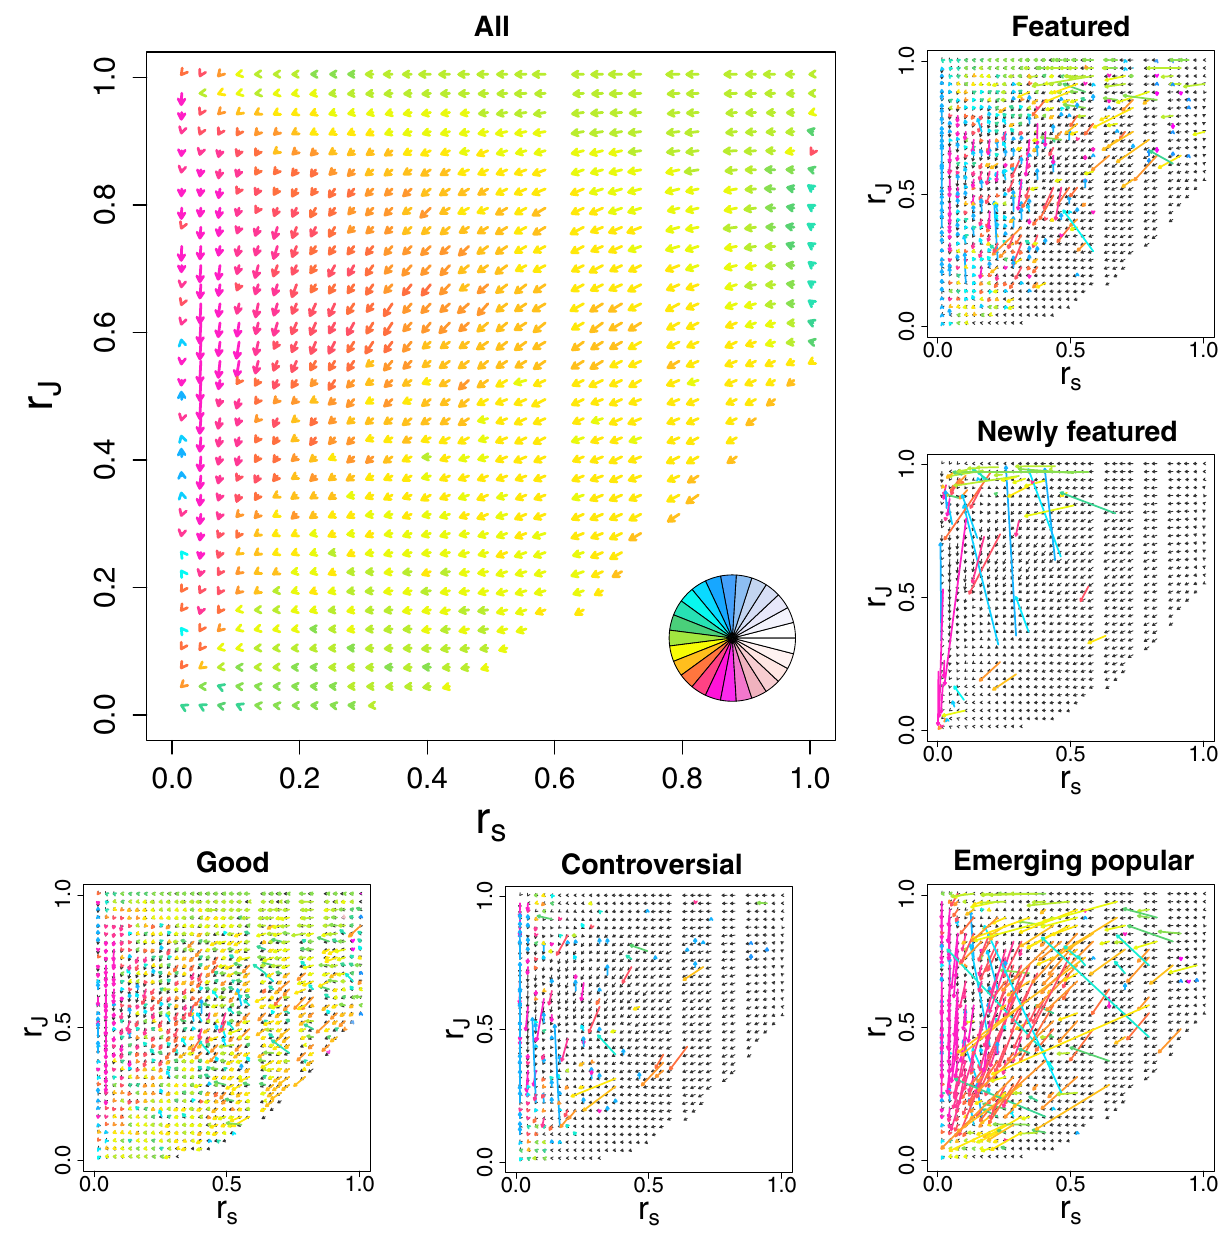
Figure 5. The temporal evolution of articles in the plane of relative ranks of the strength r s = R s / N a , and of the complexity–strength rank ratio r J = R J / N a , for the period ranging from 20th Sep 2019 to 20th Feb 2020. ( Top left) Average flows of all articles, i.e. both labelled and non-labelled articles. ( Top right to bottom right and then horizontally to the left) Flows of articles labeled as “Featured”, “Newly featured”, “Emerging popular”, “Controversial”, and “Good”. Arrows are colored according to their directions, as shown in the top left panel. Each arrow for the “Newly featured” articles corresponds to each of the 70 articles without averaging. For other panels, the average flows are plotted. The flows of labeled articles are overlaid on the average flow of all articles (grey). Note that in the low strength regime, many articles have the same strength and hence have the tie rank, which appears as the vertical blank strips in the flow